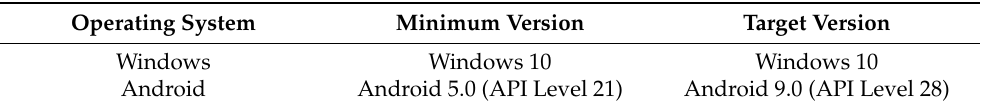
Table 2. Operating Systems Supported Versions.